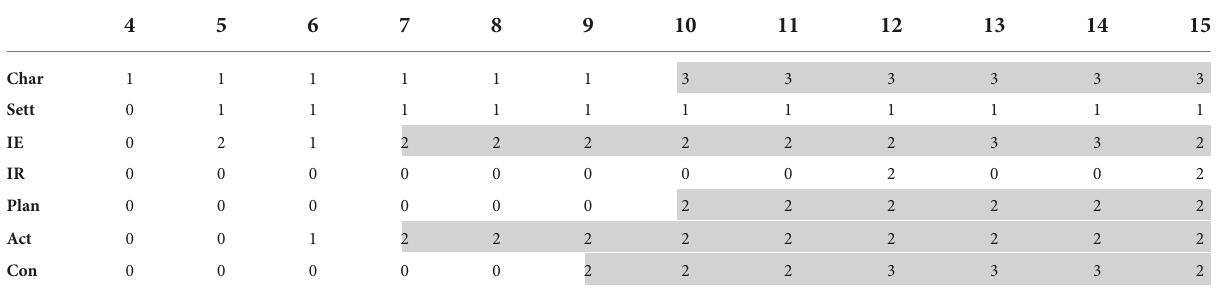
TABLE 4 Modal scores for macrostructure element by